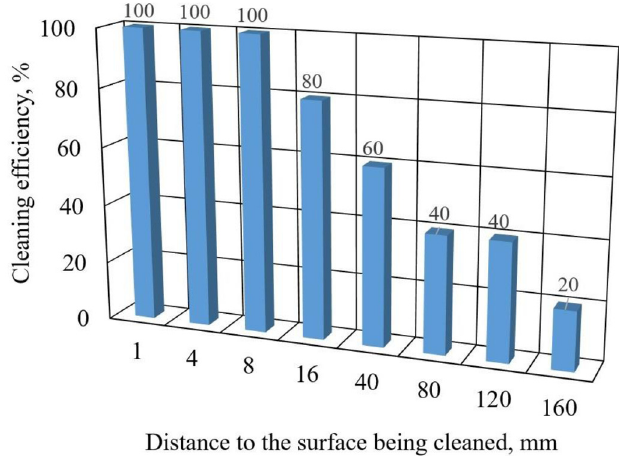
Fig. 5. Aluminum surface cleaning ef fi ciency versus distance between end of the head and surface being